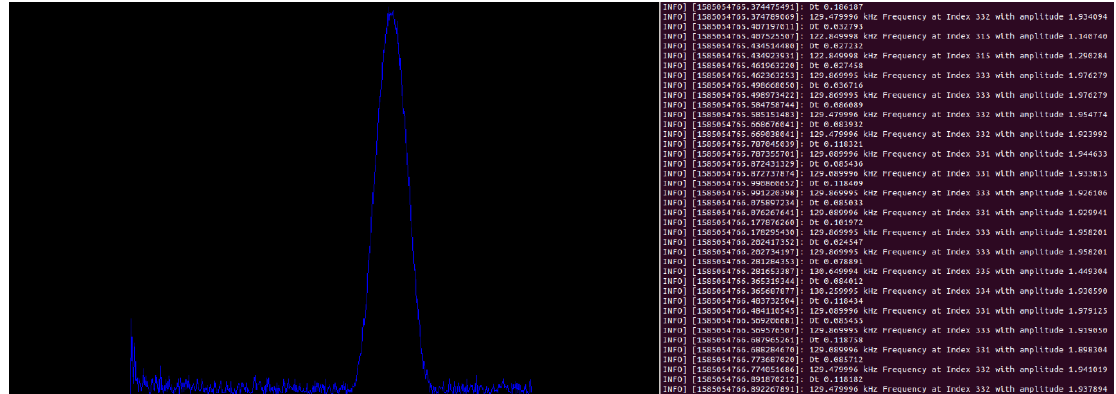
Figure 13. Real-time ADC frequency component on the PorpDAQ for a 10-s recording.